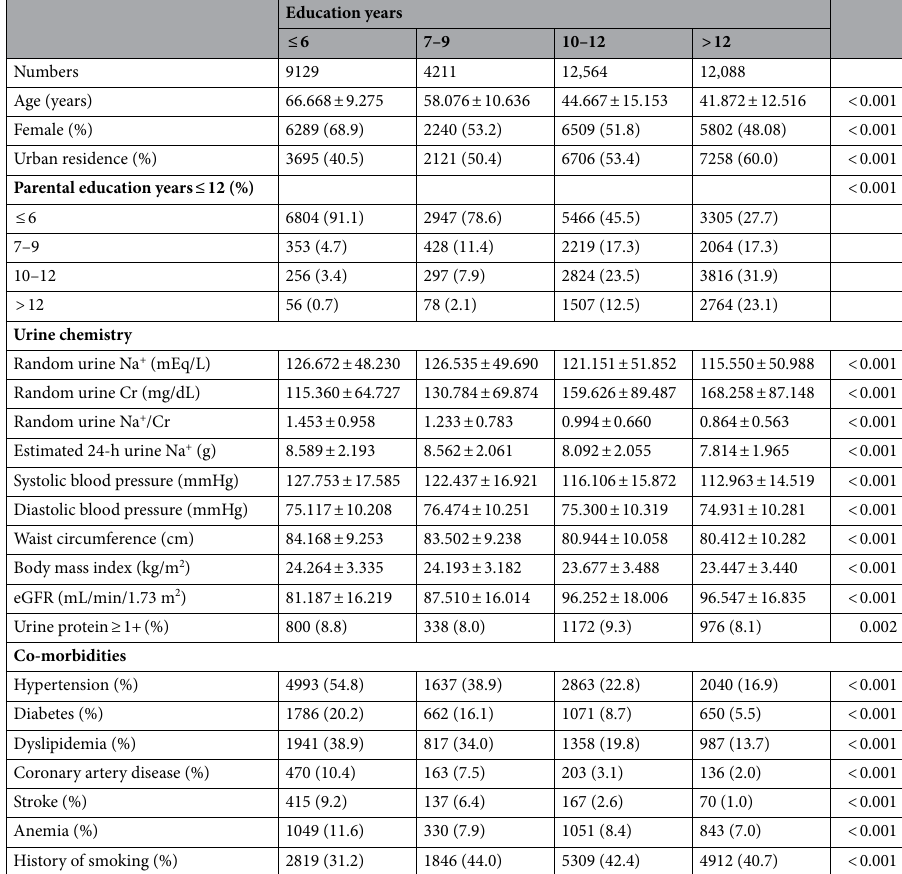
Table 1. Baseline characteristics of study subjects by educational status. Values for categorical variables are given as number (percentage); values for continuous variables, as mean ± standard deviation. P value by one- way analysis of variance and χ 2 test for continuous and categorical variables, respectively. GFR, estimated glomerular filtration